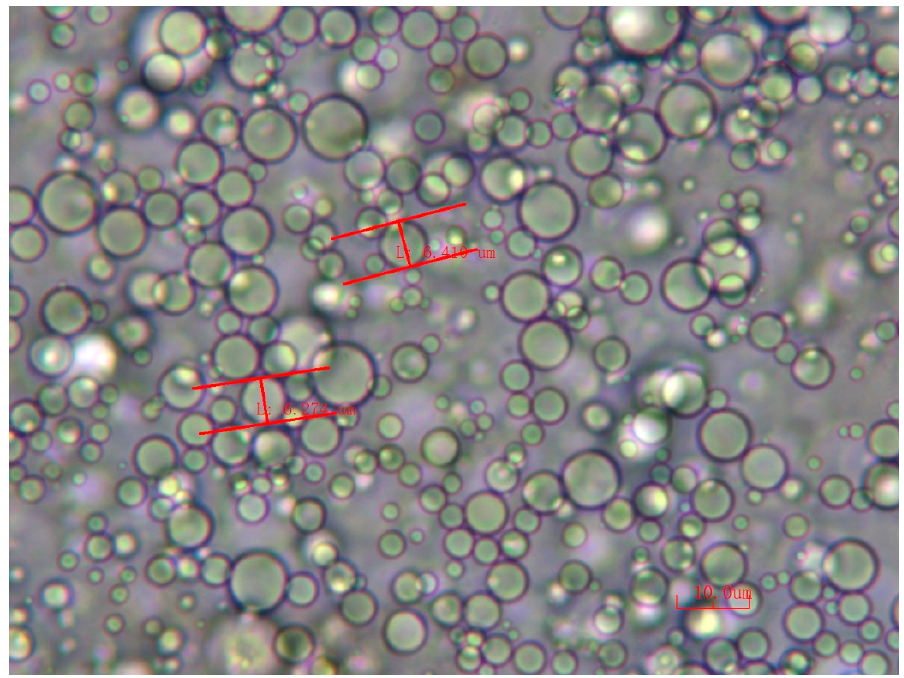
Figure 1. Micrograph of graphene oxide Pickering emulsion.